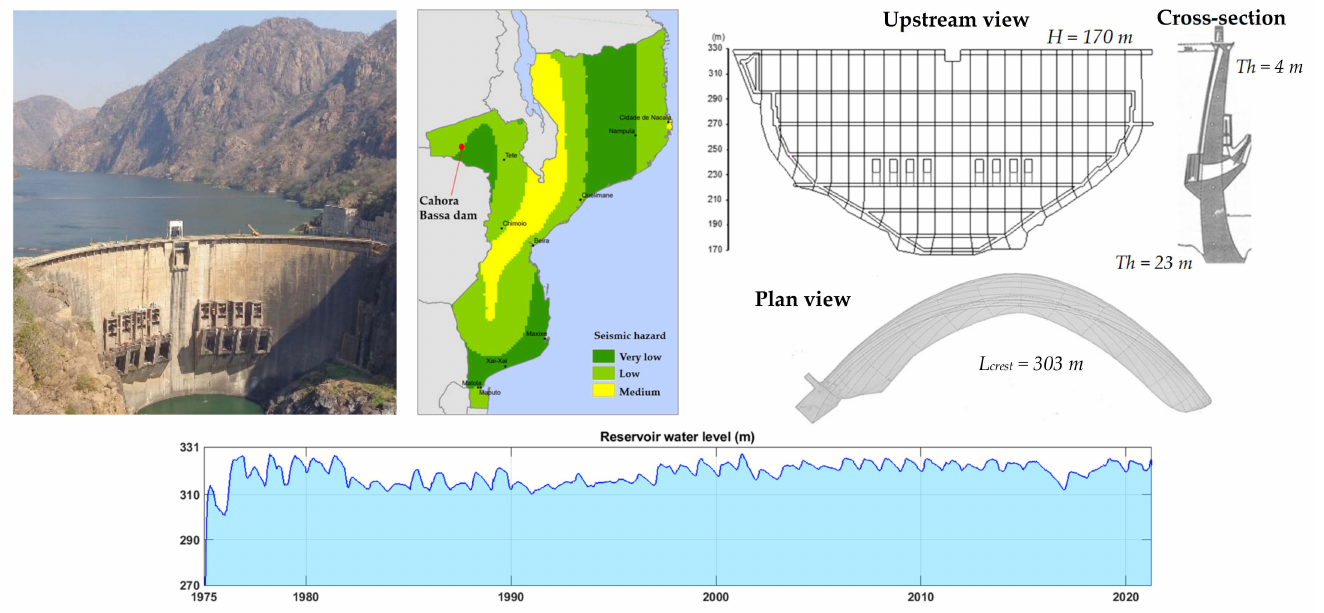
Figure 11. Case study II: Cahora Bassa Dam. Location and seismic hazard zones. Upstream, cross- section and plan views. Variation of the reservoir level over